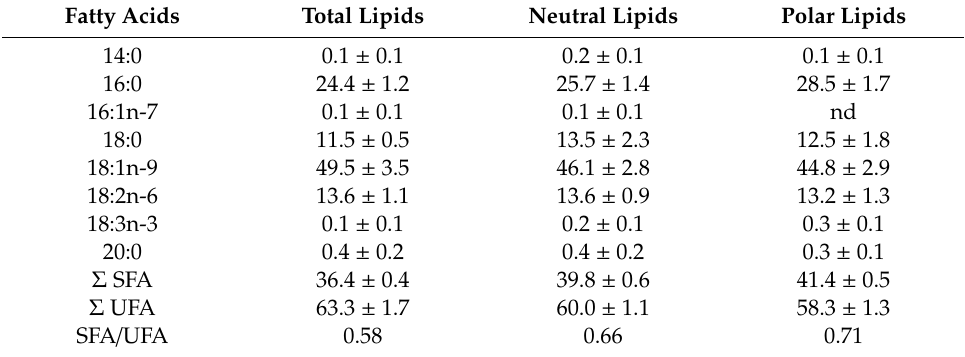
Table 2. Fatty acid composition (% of total fatty acids) of total, neutral, and polar lipids obtained from Madhuca ellitica